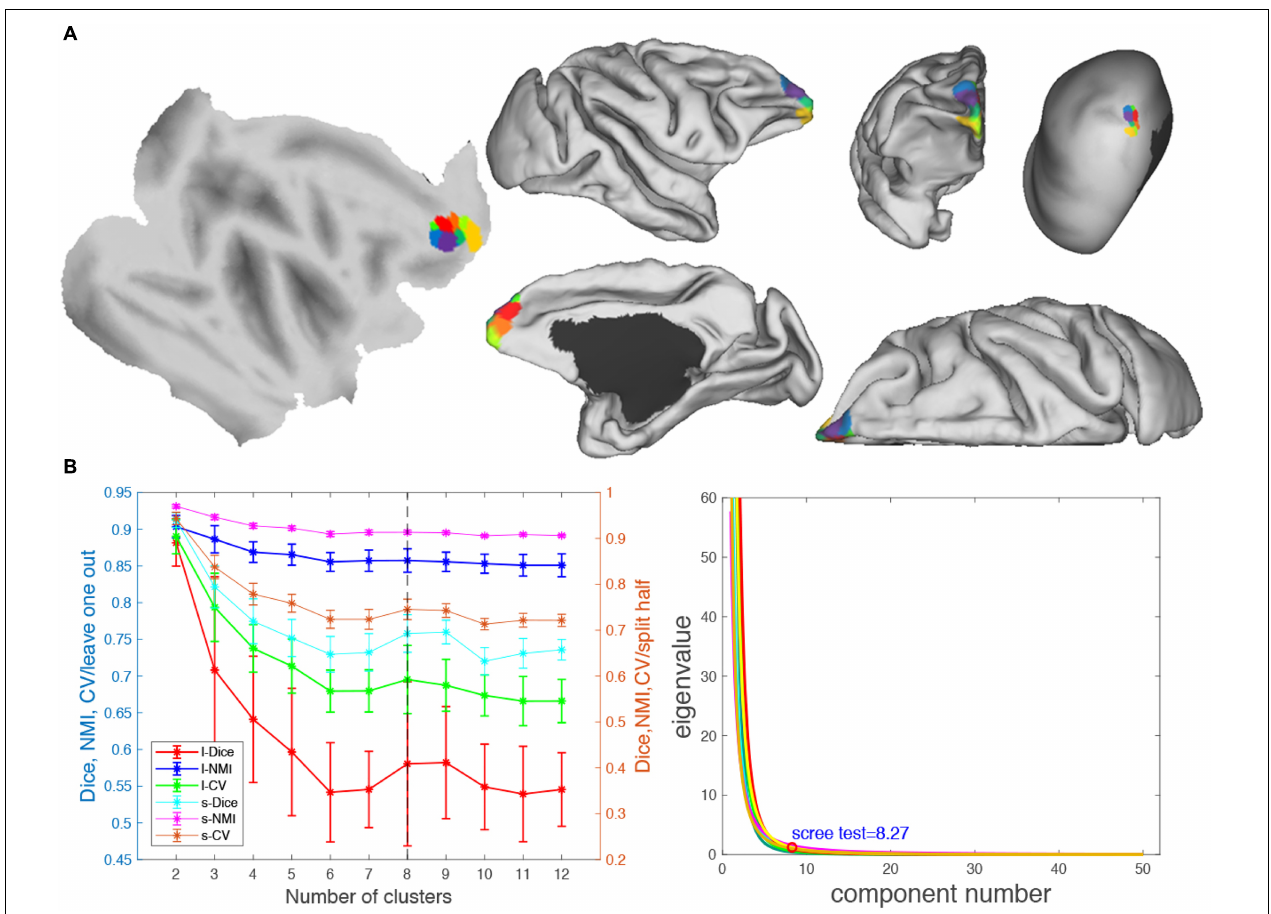
FIGURE 8 | Parcellation results of right frontal pole (FP.R). (A) The maximum probability maps (MPMs) of FP.R with eight clusters in flat, fiducial (lateral, medial, anterior, and superior) surface, with very inflated (dorsal-lateral) view. (B) Validity indices of the parcellation results for FP.R. Thereinto, the results of Dice, NMI, and CV using leave-one-out (l-Dice, l-NMI, and l-CV) and spilt-half (s-Dice, s-NMI, and s-V) resampling technique (left) and principal component analysis (PCA) (right) suggest that the optimal result of right clusters seems the most reasonable. The error bars represent standard